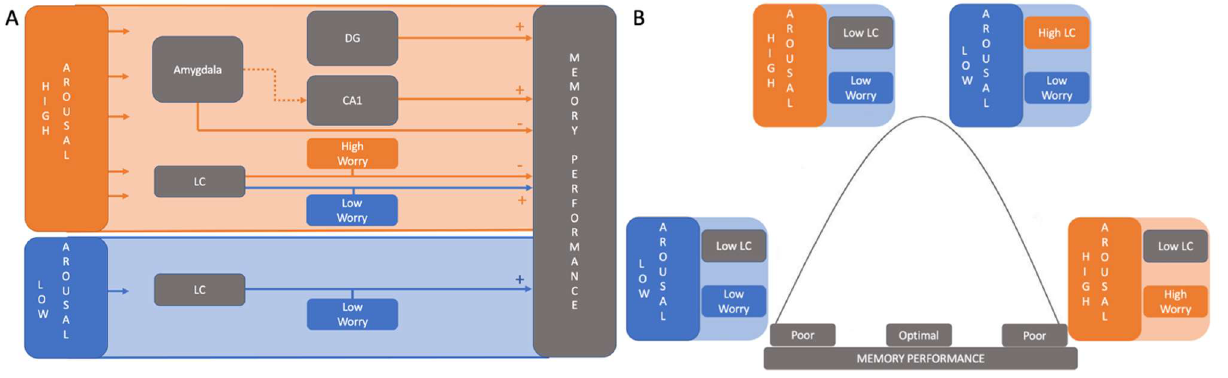
Figure 5. Schematic representation of the interactions and interpretations of the results in our paper. ( A ) High arousal effects are represented in orange. Low arousal effects are represented in blue. + represents higher ROI activation that is related to an improvement in memory performance. – represents a lower memory performance related to higher ROI activation. The dotted line depicts a relation we did not test but hypothesize based on previous literature. ( B ) Represents the model we hypothesize in which for optimal memory performance one source of arousal (high arousal stimuli or LC activation) leads to optimal performance which two sources of arousal push too far and leads to poor memory performance.